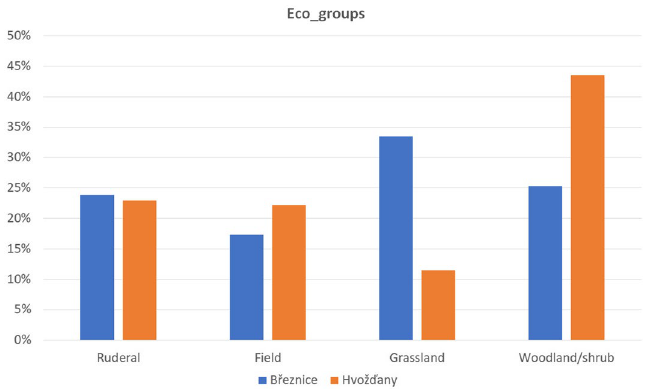
Figure 4. Březnice and Hvožďany. Reconstruction of the environment of the origin of macroremains.